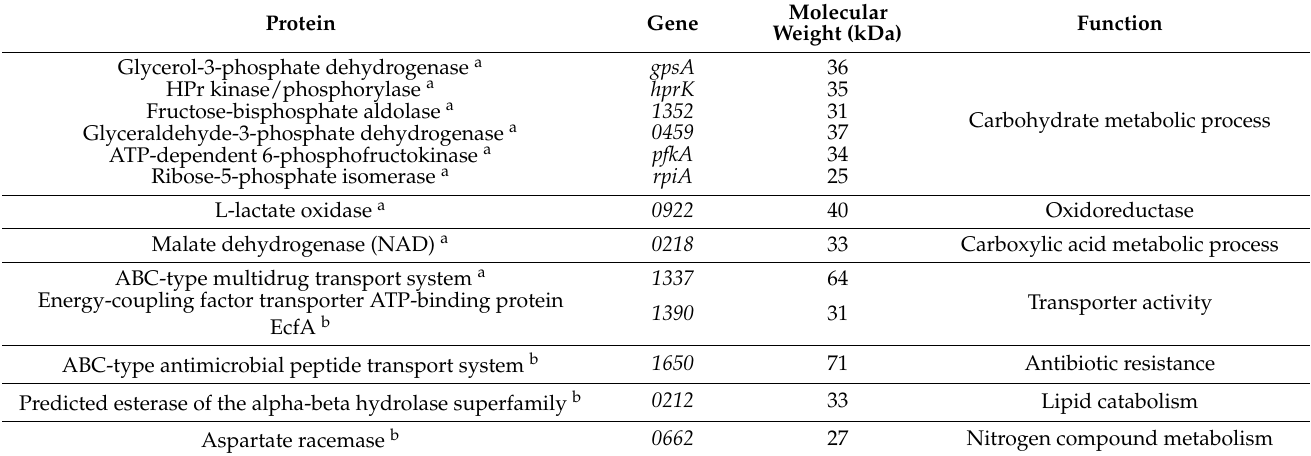
Table 7. List of the top 13 downregulated proteins and those found in the control treatment only.